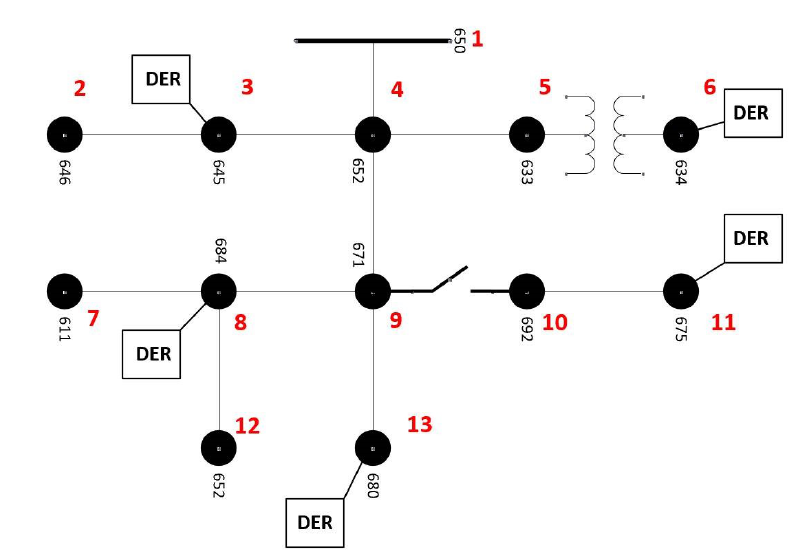
Figure 3. IEEE 13-bus Test Feeder with added DER